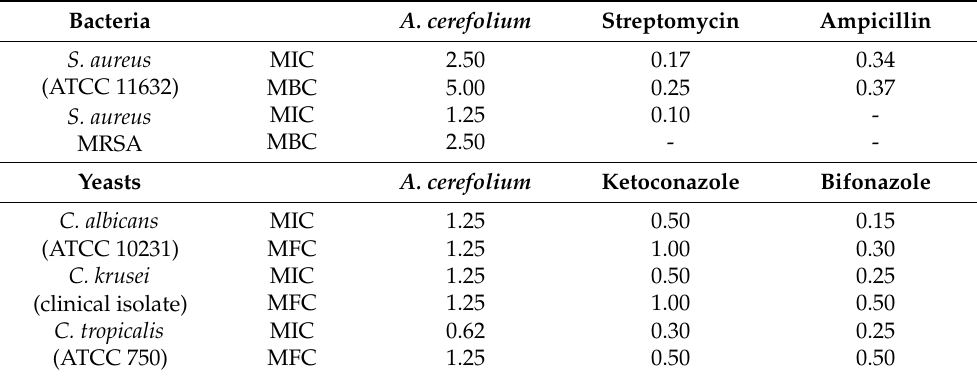
Table 3. Antimicrobial activity of the A. cerefolium methanolic extract (mg/mL). Bacteria